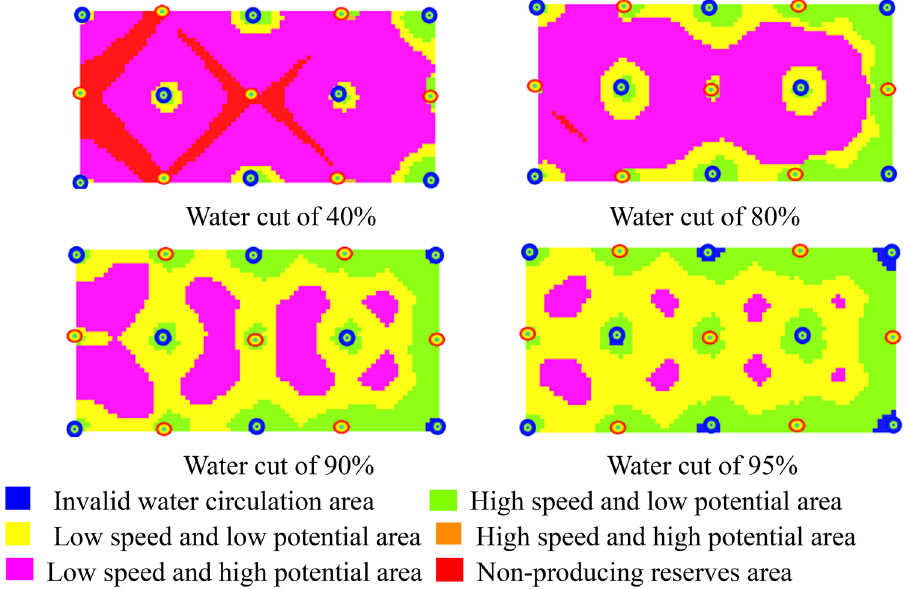
Fig. 8 Seepage field partition diagram of horizontal perme- ability model